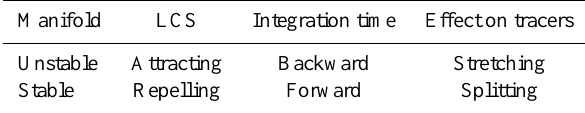
Table 1. Properties of attracting and repelling LCSs. Manifold LCS Integration time Effect on tracers